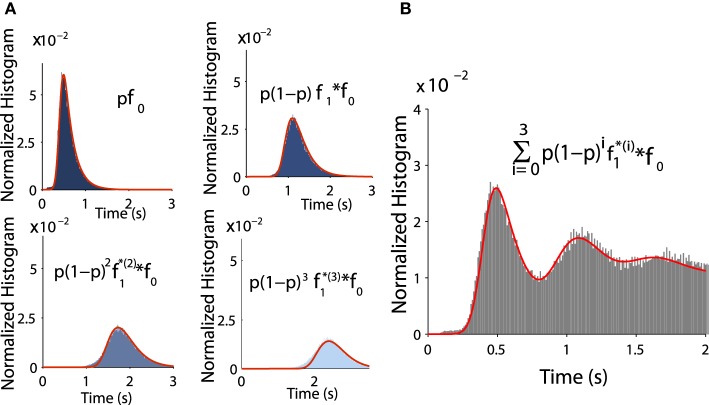
Distribution of exit time conditioned by the winding number. (A) Comparison between histograms of trajectories of 1, 2, 3, and 4 turns and formulae f0 and fk (in red) (B) Comparison between the histogram of exit time obtained from subfigure A with the analytical formula (in red) Equation (8).